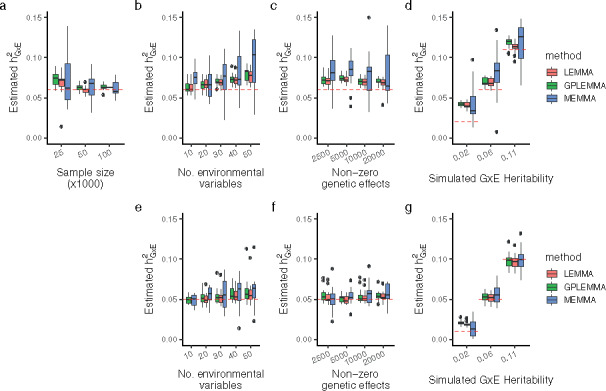
PVE estimation. Estimates of the proportion of variance explained by GxE effects by LEMMA, MEMMA and GPLEMMA whilst varying the number of environments, the number of active environments, the number of non-zero SNP effects and GxE heritability. All simulations constructed with the baseline phenotype. a–d Simulations results using N=25K samples and M=100K variants by default, e–g show simulation results using N=100K samples and M=300K variants. Results from 15 repeats shown